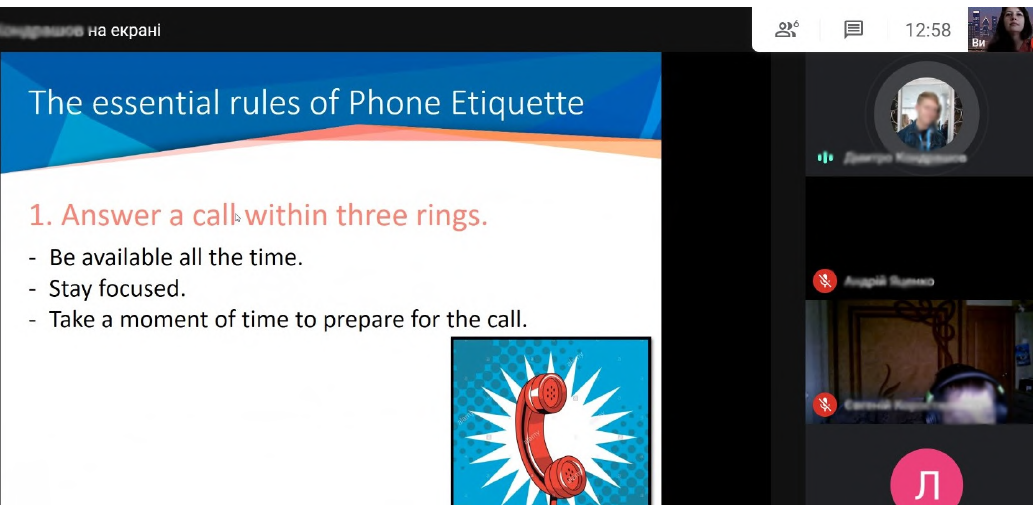
Figure 65: Presentation of paper